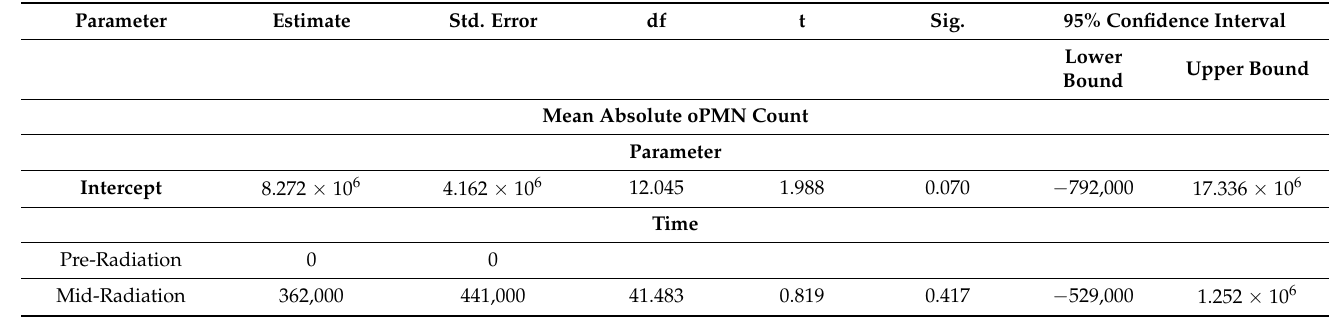
Table A4. The fixed effect estimates of the mean oPMN absolute counts across the four time